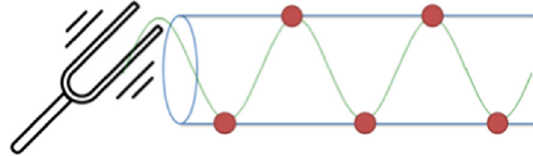
FIG. 1. Because of distractor 1.c, acoustical resonance occurs when the amplitude is equal to the